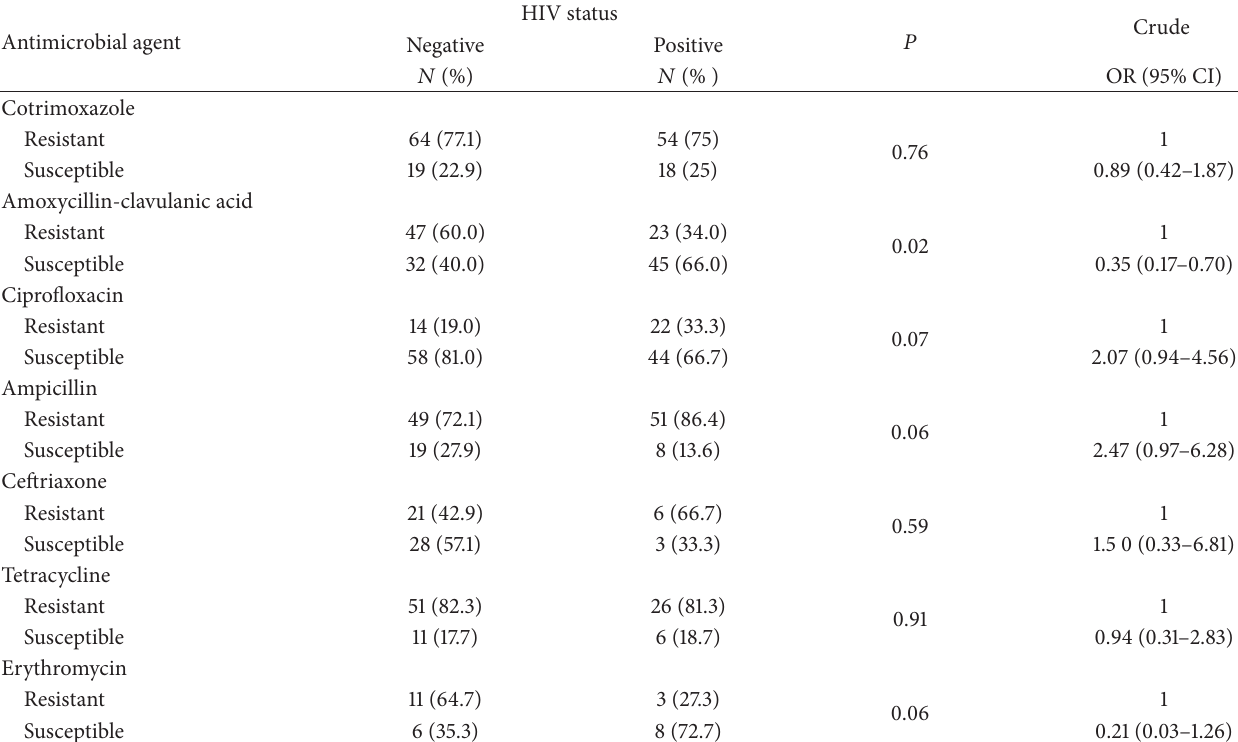
Table 3: Antimicrobial resistance patterns based on HIV status.